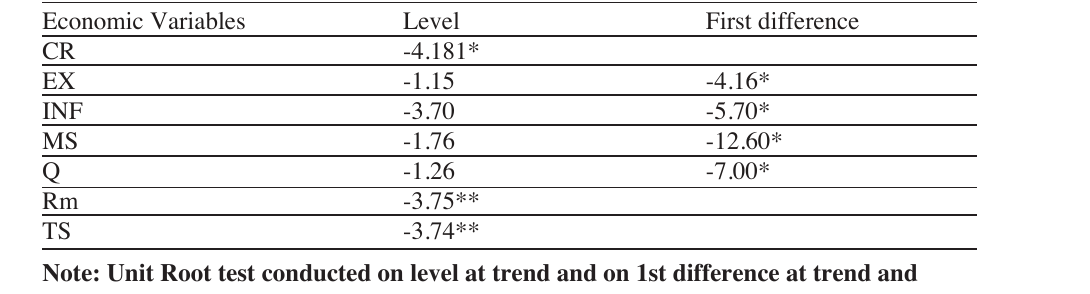
Table A1: Unit Root Test (Economic Variables)